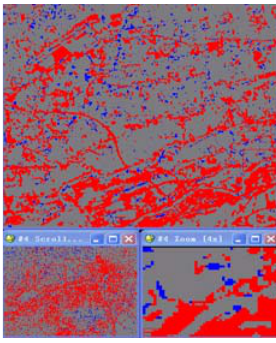
Fig.10 Change detection of man-made area (Increased man-made area in red, decreased man-made area in